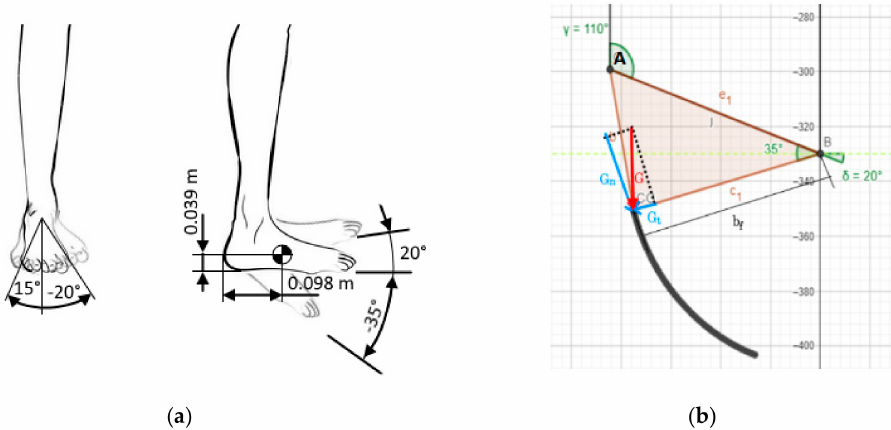
Figure 1. Input biomechanical data: ( a ) range of motion and position of the center of gravity of the foot ( b ) geometrical relationship between the center of gravity and